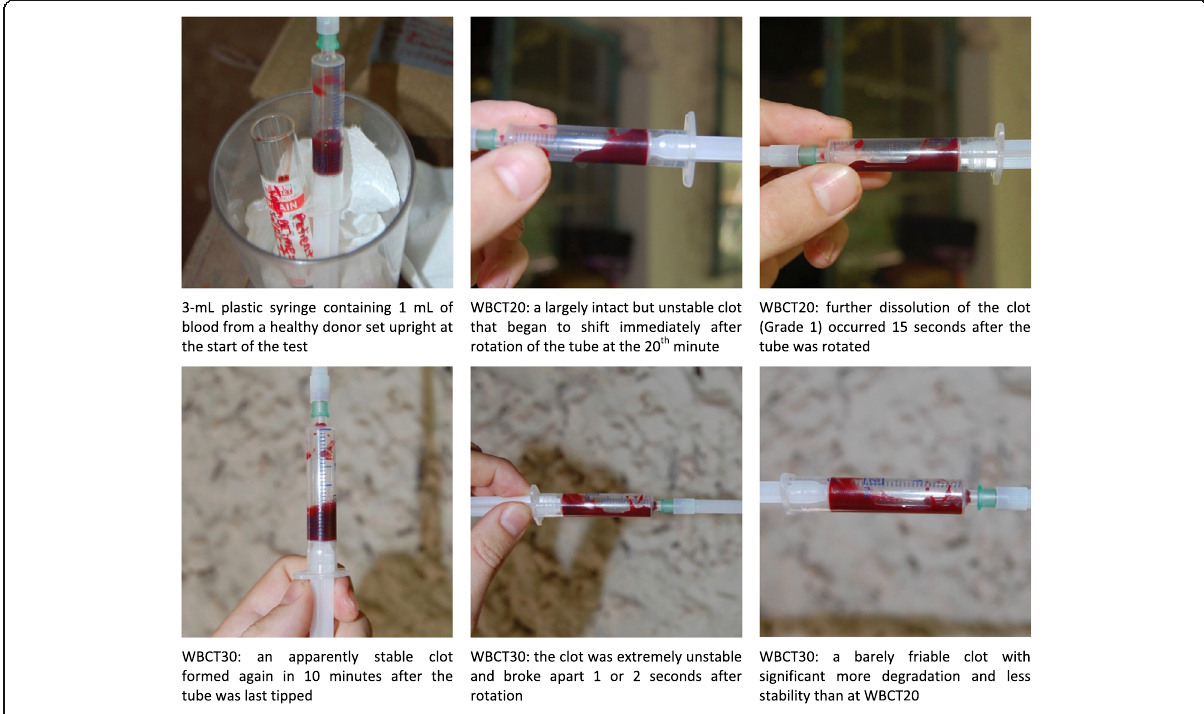
Fig. 2 Blood from healthy donors failed to clot normally in plastic syringes at both reading